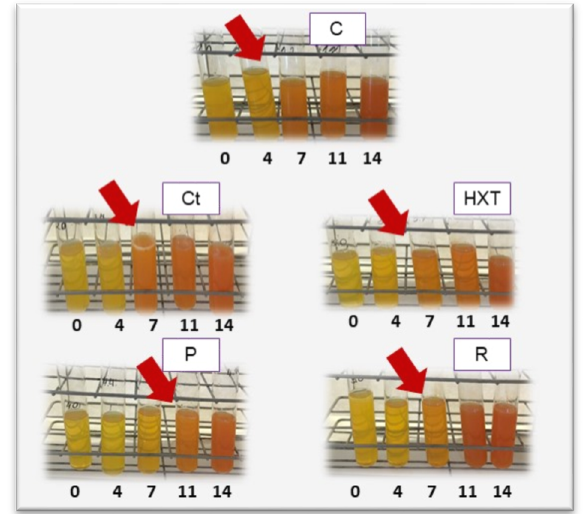
Figure 2. Ammonia determination with the Nessler colorimetric test in raw fish patty samples up to 14 days at 4 °C under simulated retail display conditions. Control sample (C); sample enriched in citrus (Ct); sample enriched in hydroxytyrosol (HXT); sample enriched in pomegranate (P); sample enriched in rosemary (R).